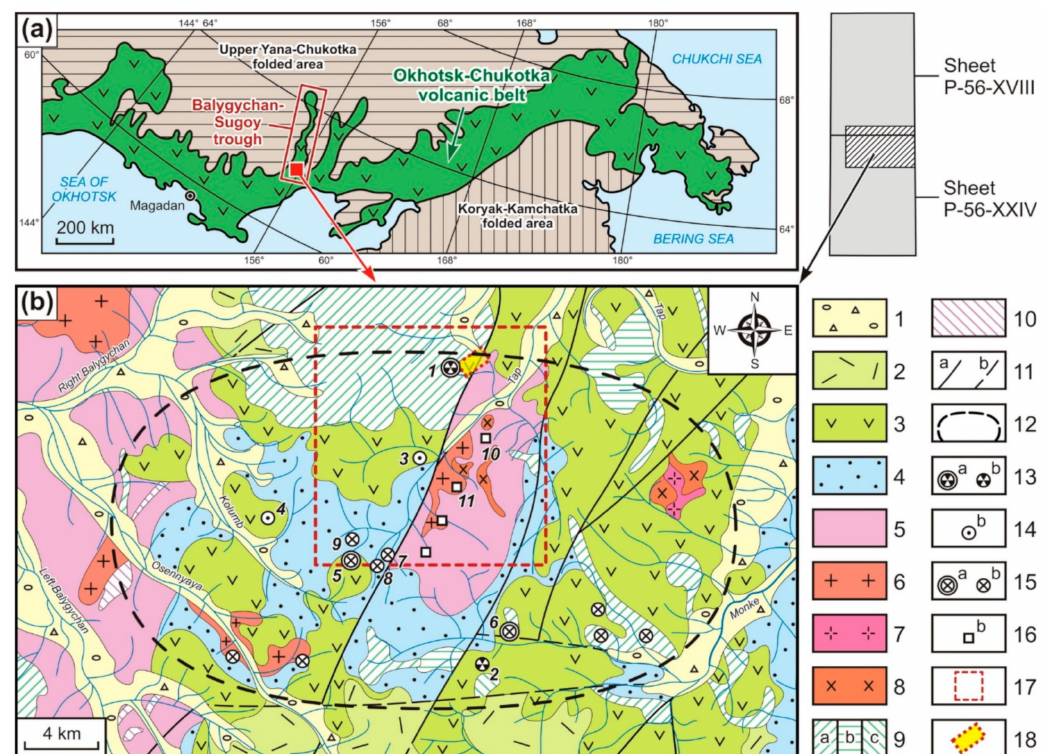
Figure 1. The investigation area location in the Okhotsk-Chukotka volcanic belt (OCVB) ( a ); schematic geological map of the Balygychan-Sugoy trough’s southern part (including the Pestrinsk silver-bearing system (SBS)) ( b ). The image was constructed by the authors of the present paper using data from [53,60–64] with additions by [56] and materials from the Dukat geological exploration enterprise. On the legend: 1—Quaternary sediments; 2—Late Cretaceous rhyolites, rhyolitic ignimbrites and tuffs and rhyodacites (Nayakhan suite); 3—Early-Late Cretaceous andesites, andesite-basalts, tuffs and tuffolavas and dacites (Tavatum suite); 4—Jurassic siltstones, argillites, sandstones, tuffaceous sandstones, tuffites and ash tuffs; 5—Triassic sandstones, siltstones, argillites, tuffs, tuffites, sandy argillites and calcareous sandstones;